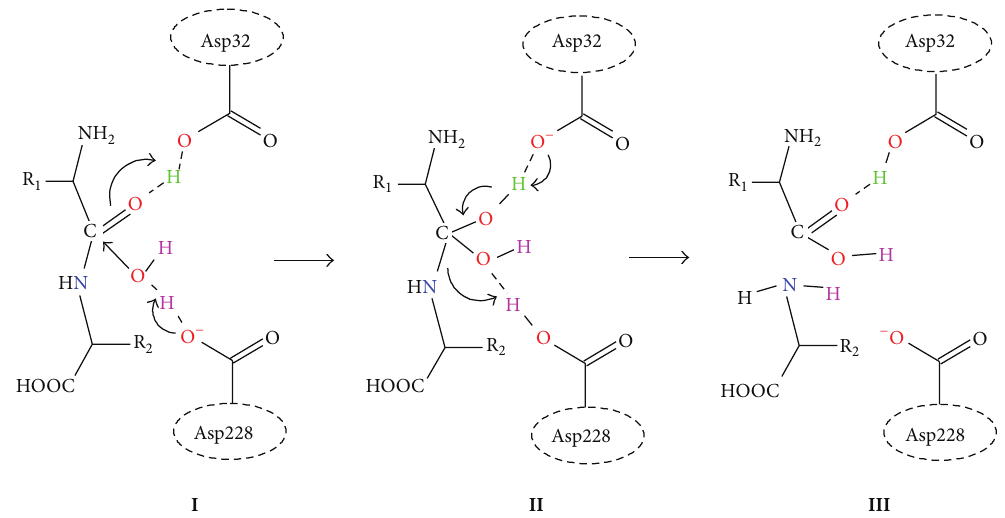
Figure 3: General acid-base mechanism utilized for peptide hydrolysis.